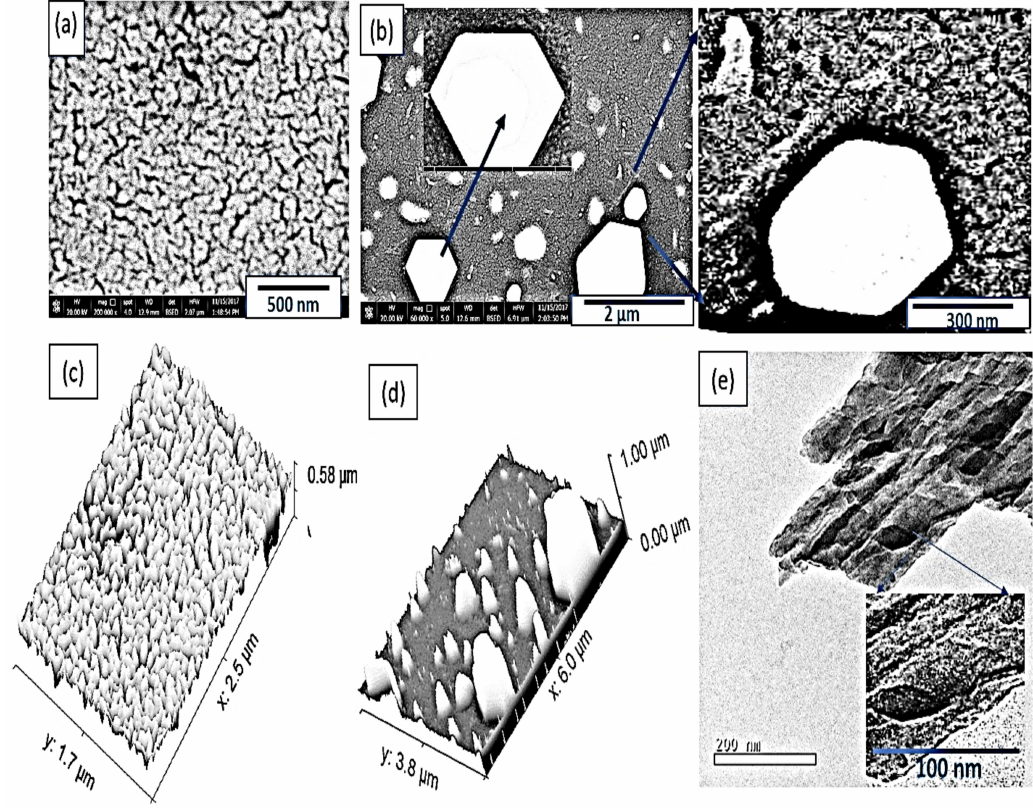
Figure 2. The SEM and modeling images for ( a , c ) PANI, ( b , d ) PANI/PbI 2 nanomaterials. ( e ) TEM image of the PANI/PbI 2